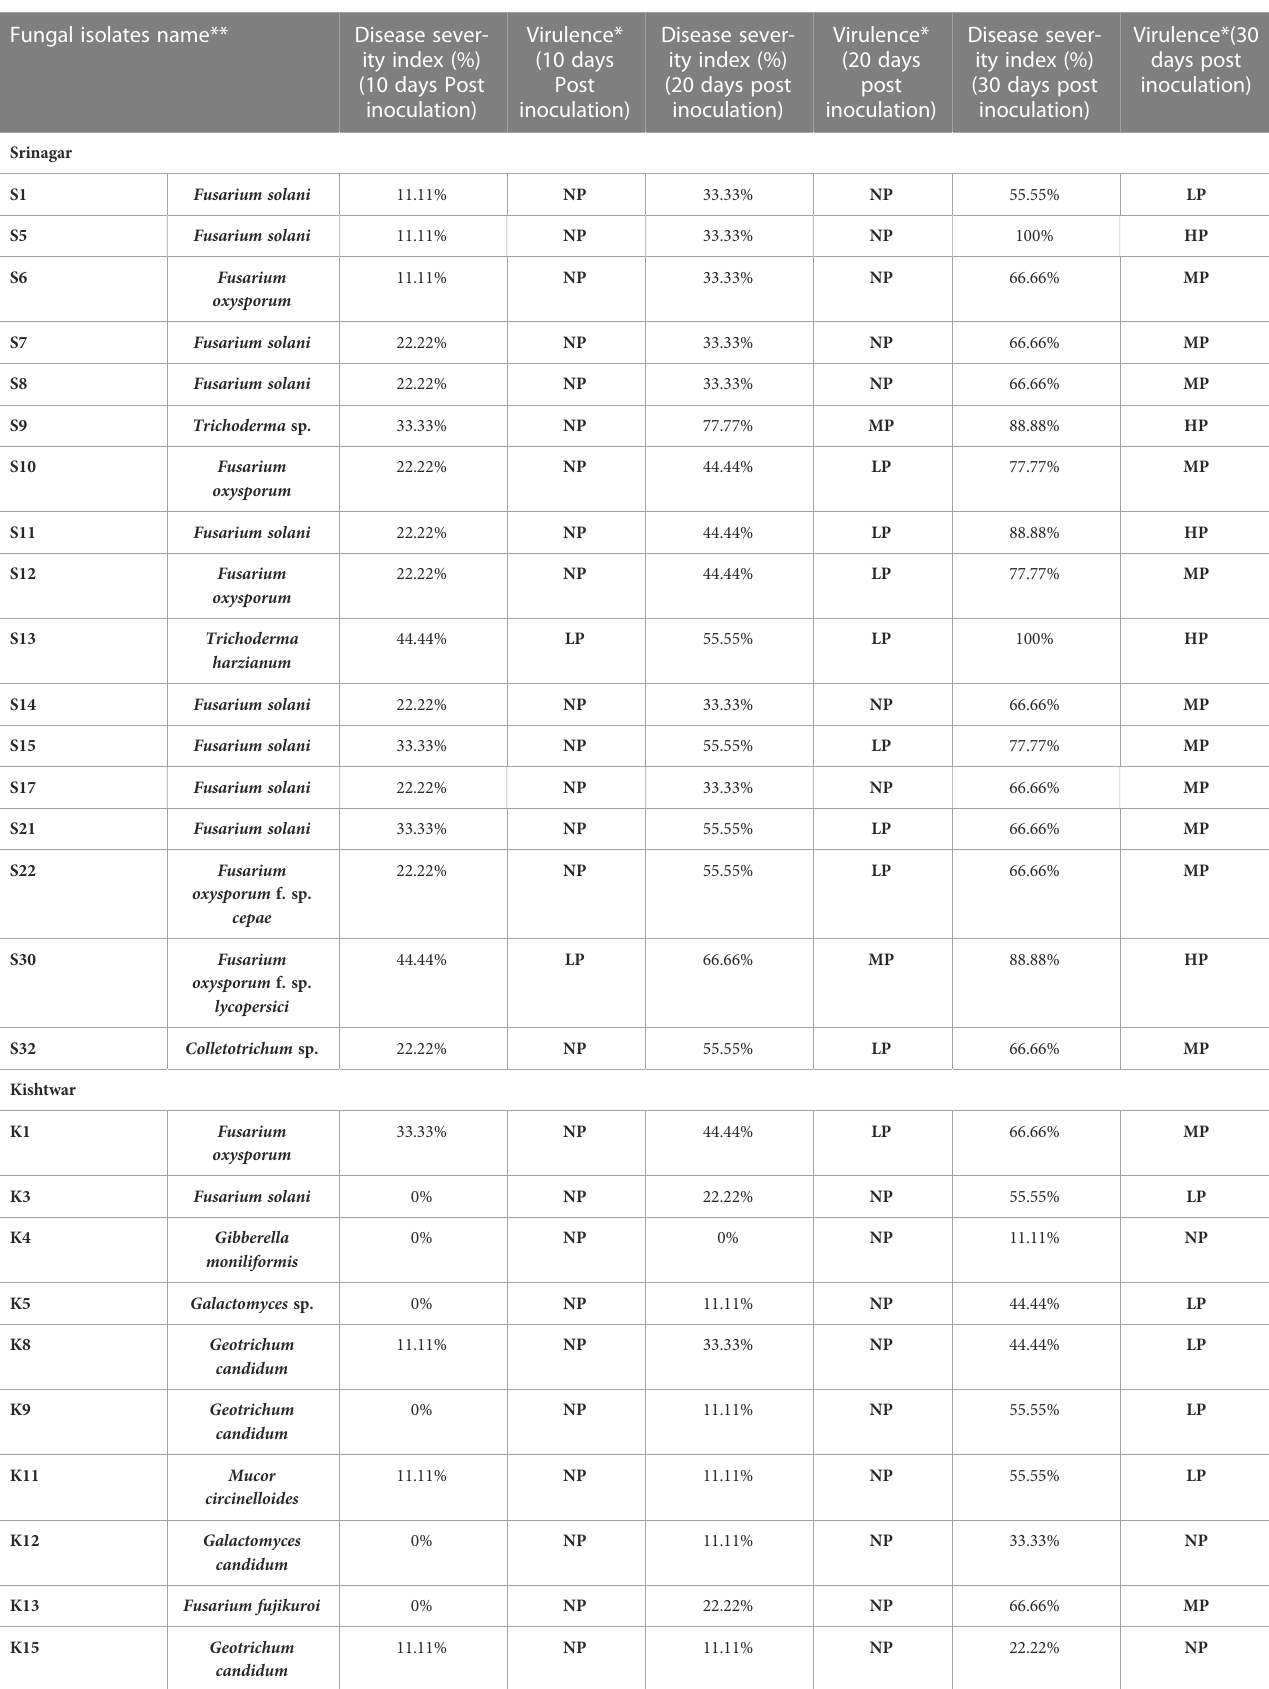
TABLE 5 Root rot pathogenicity pro fi ling of fungal species isolated from Srinagar, Kishtwar and Ramban location. Fungal isolates